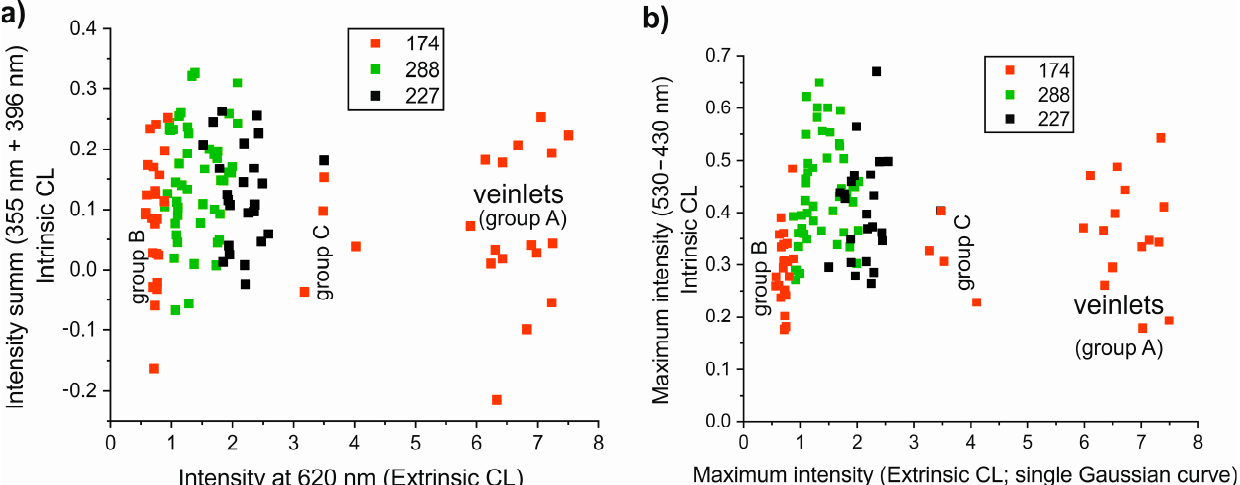
Figure 4. Comparison of data derived from calcite CL-spectra: ( a ) discrimination of the studied samples using the intensity plot after [16] (Figure 3 in the article); ( b ) modified plot of [16], with maximum intensity of extrinsic CL based on the fitting of the main band by a single Gaussian curve (centred between 605 and 638 nm) and the intensity of intrinsic luminescence plotted as the maximum intensity value of the wavelength range of 430–530 nm. Although the two graphs ( a , b ) are slightly different, neither of them provide straightforward discrimination of calcite samples from the three studied localities, based on statistical parameters of CL-spectra only. Most of the data represent the groundmass calcite of the studied samples, except for the “veinlets” data. Sample No. 174—Raspenava, sample No. 227—Bohdane č , sample No. 288—Nedv ě dice. Three groups of sample No. 174 (A—veinlets, B—groundmass of the calcitic type of dolomitic marble, C—groundmass of the dolomitic marble type with secondary calcite veins) are indicated by labels.